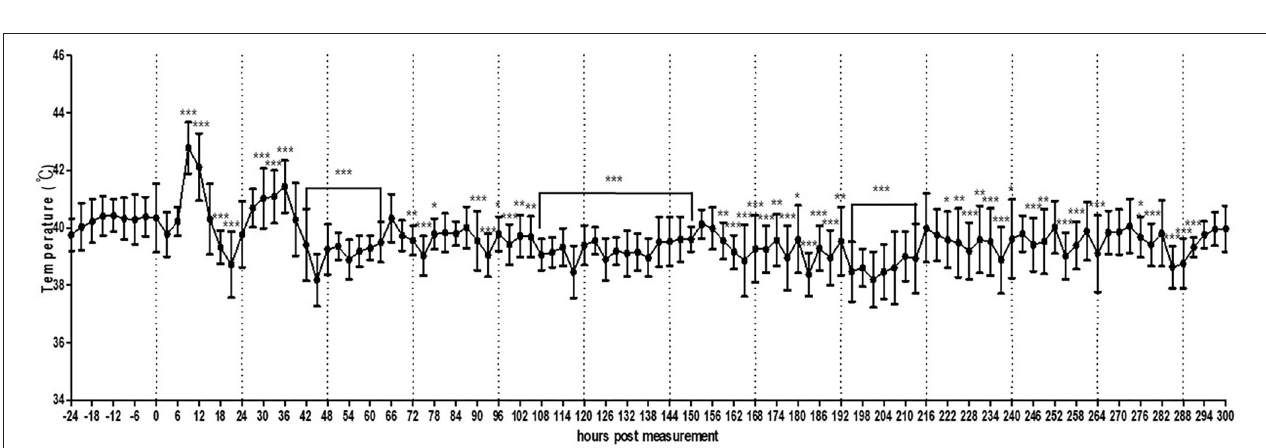
FIGURE 3 | Average temperature per 3h interval before and after HPAI virus challenge in a duck intranasally exposed to the virus at a dose of 10 8.0 EID 50 /bird. Duck was further monitored several more hours after death without removal. The error bars represent standard deviations of 36 5-min time points. Statistical significance was determined using ANOVA followed by Bonferroni post-hoc test. *** P < 0.001; ** P < 0.01; * P < 0.05.